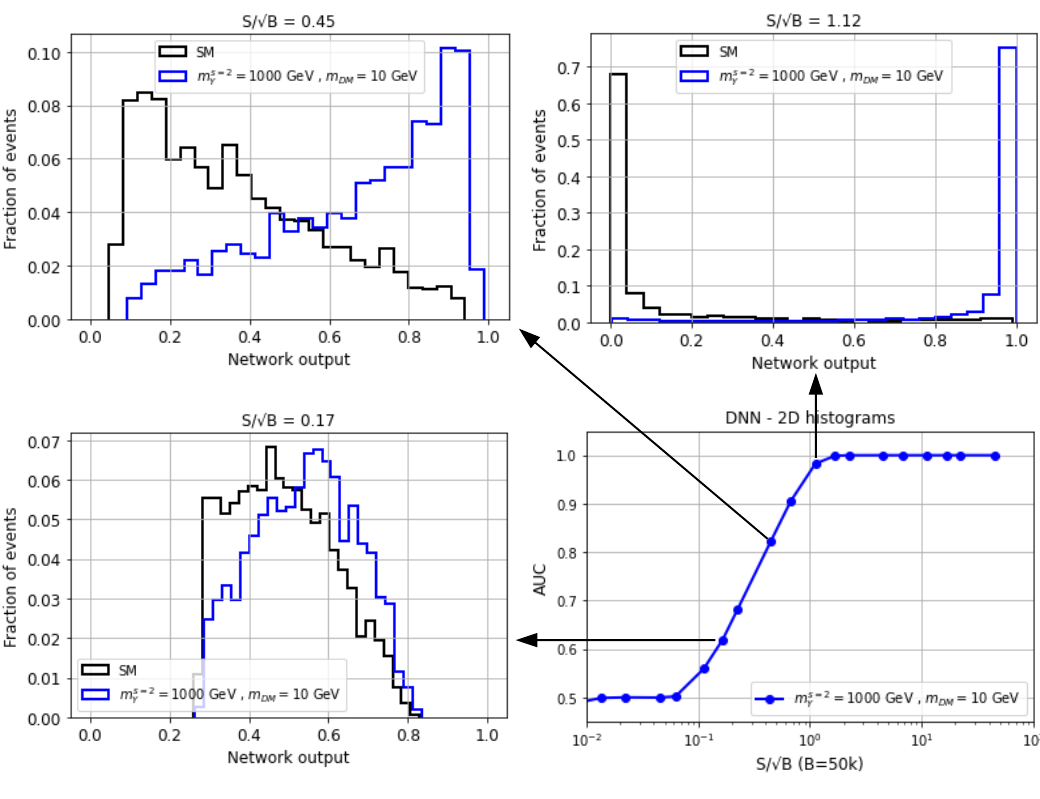
(cid:112) B = 1.12 (top-right), 0.45 (top-left) and Figure 8: Network outputs for S / = 1000 GeV and 0.17 (bottom-left), considering the benchmark model with m s = 2 Y = 10 GeV, whose performance and AUC values can be seen on the bottom-right m DM panel. The outputs black (blue) curves represent the results when test samples of SM-only (new physics plus SM) histograms are